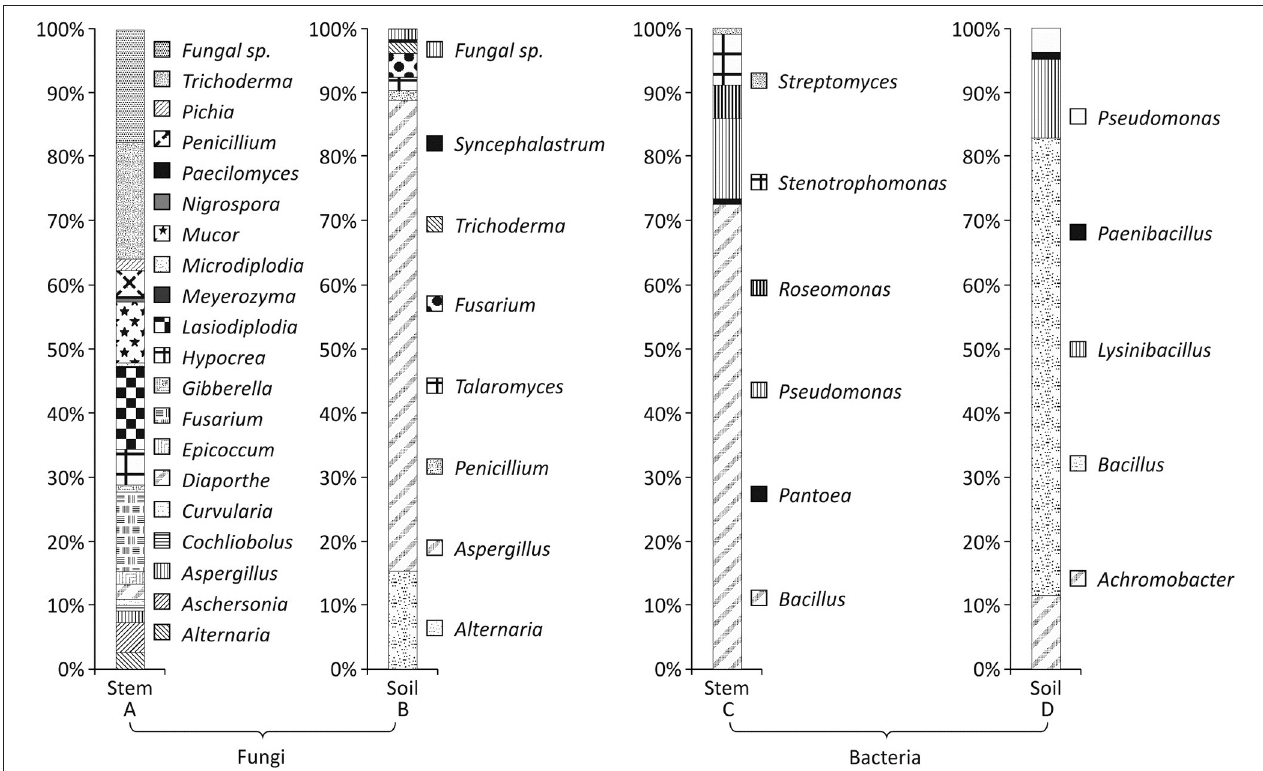
FIGURE 2 | Distribution of fungi (A,B) and bacteria (C,D) in stem and soil samples at genus